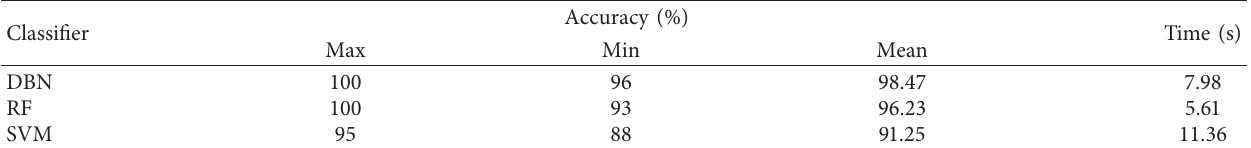
Figure 16: The two-dimensional view of the first two features by DTCWPT-GCMAAPE: (a) adopting t-SNE; (b) without adopting t-SNE; (c) adopting LDA. Table 4: The classification results of different classification models for 30